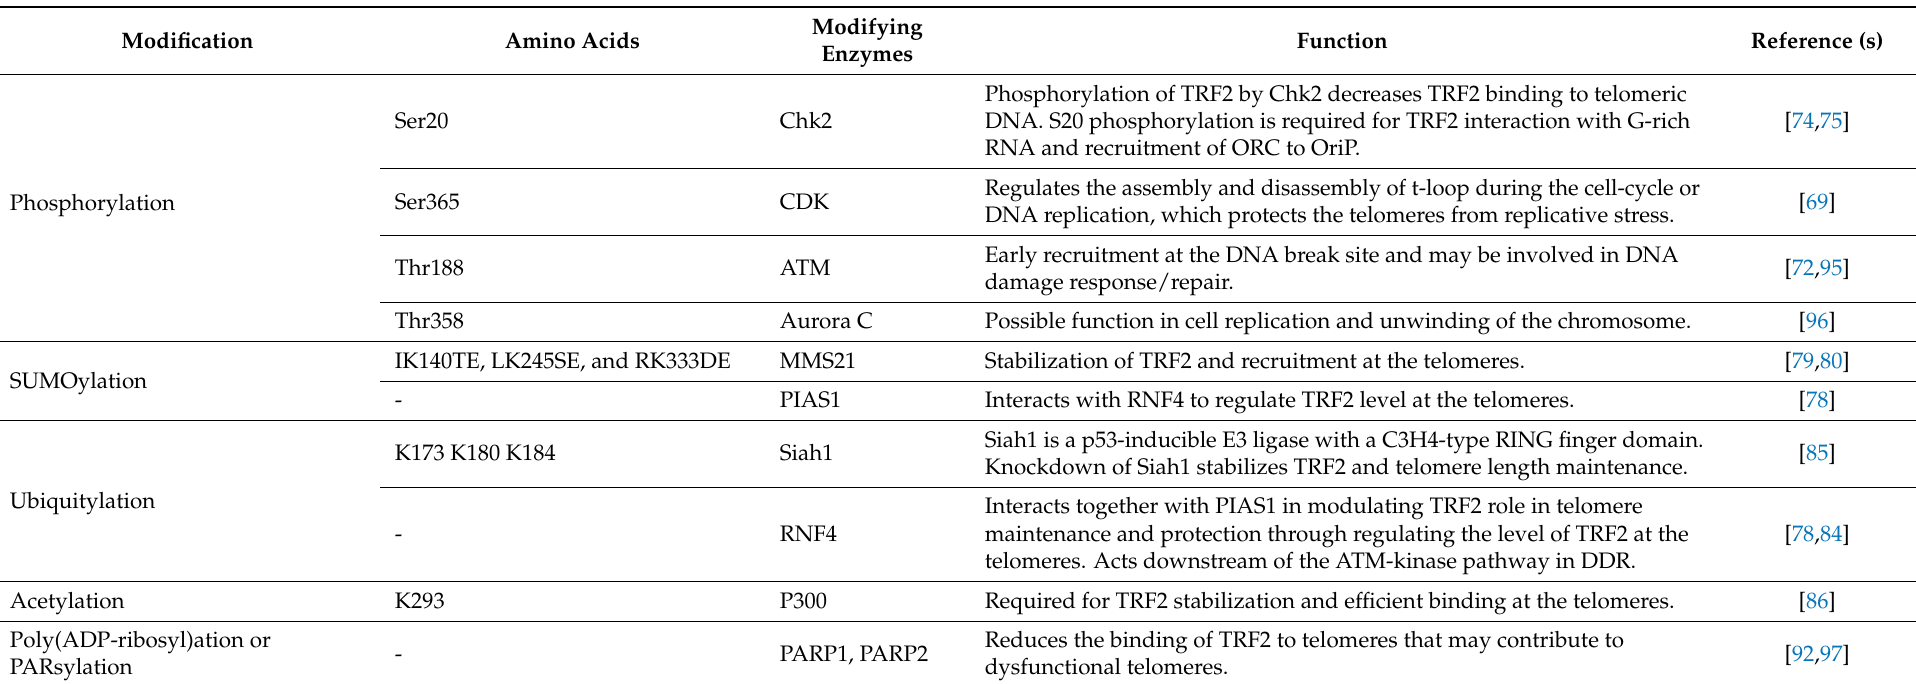
Table 1. Post-transcriptional modifications of